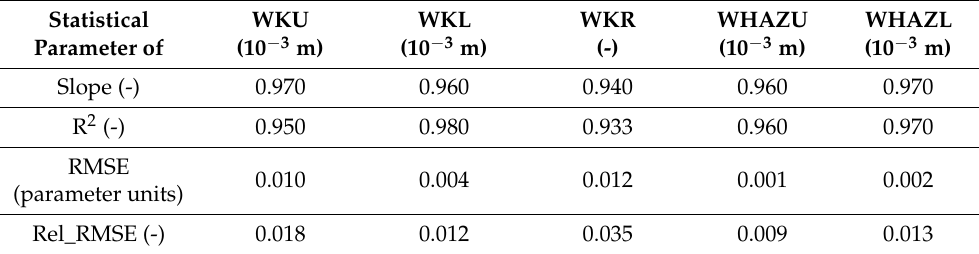
Table 5. Statistical parameters of the ANN